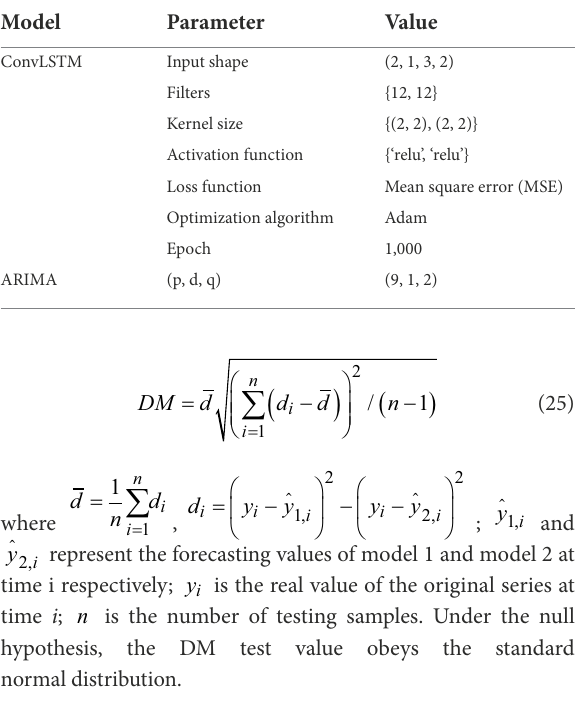
TABLE 1 Parameters and hyperparameters of the proposed